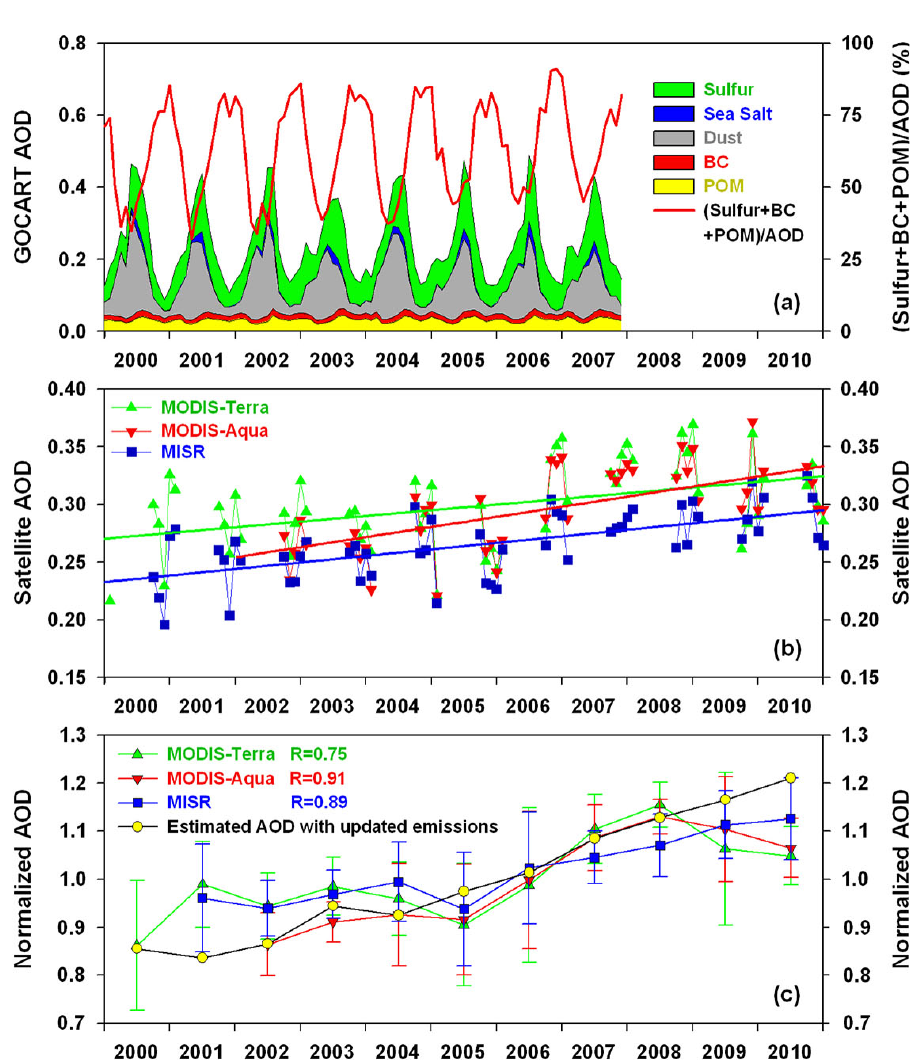
Fig. 11. AOD from GOCART model simulations and the MODIS (Terra and Aqua) and MISR satellite instruments over India. (a) Monthly variation of GOCART AOD and the combined contribution from sulfate, BC, and POM to total AOD during 2000–2007. (b) Monthly mean variability of satellite AOD retrievals during October to February 2000–2010. Solid lines represent the linear tendencies. (c) Trend of estimated AOD due to SO 2 , BC, and OC emissions, and evolutions of satellite AOD averaged between October and February during 2000–2010. R values shown are the correlation coefficients of each satellite AOD with estimated AOD. Error bars express one standard deviation of the monthly